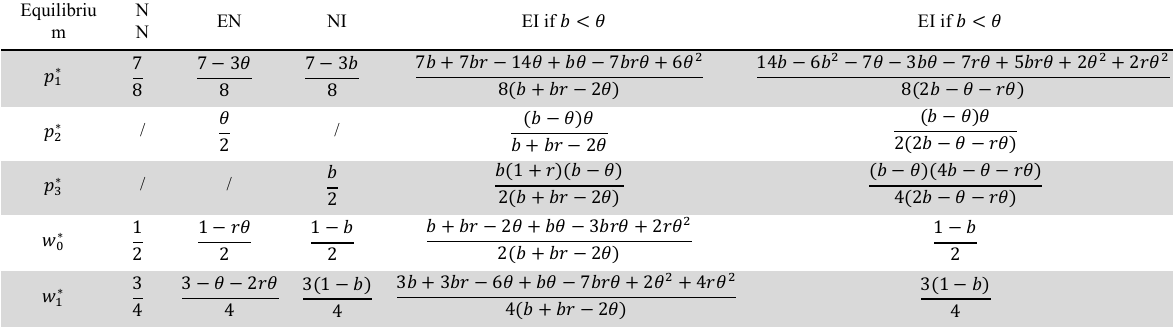
Optimal outcomes under different scenarios Equilibriu